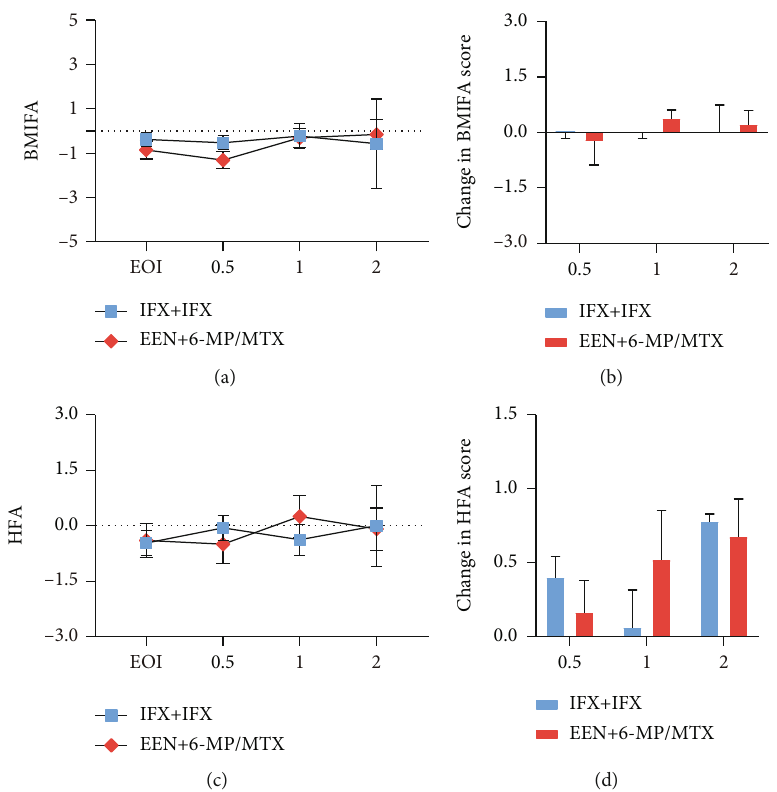
Figure 4: The linear growth outcomes and nutritional status during longitudinal follow-up. (a) BMI z -score and (b) HFA z -score of children treated with EEN+6-MP/MTX or IFX+IFX and 0.5-, 1-, and 2-year follow-up. Changes in (c) BMI z -score ( Δ BMI) and (d) HFA z -score ( Δ HFA) comparing with the end of induction (EOI) remission therapy during maximum 2-year follow-up. ∗ P < 0 : 05 ; ∗∗ P < 0 : 01